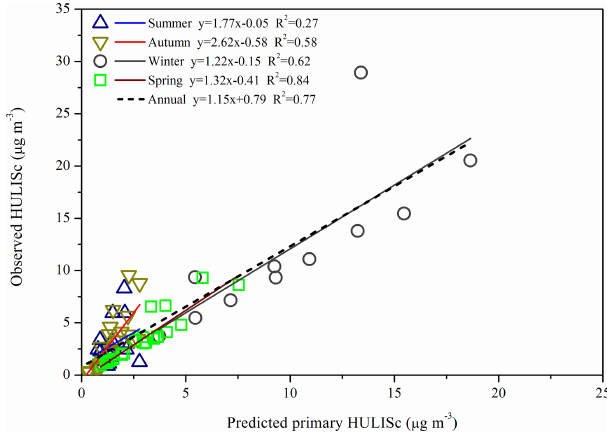
Figure 4. Scatter plot of predicted primary HULISc and observed HULISc concentrations. Concentrations of different seasons are represented by different shapes with different colors. Linear regres- sions are also given with corresponding